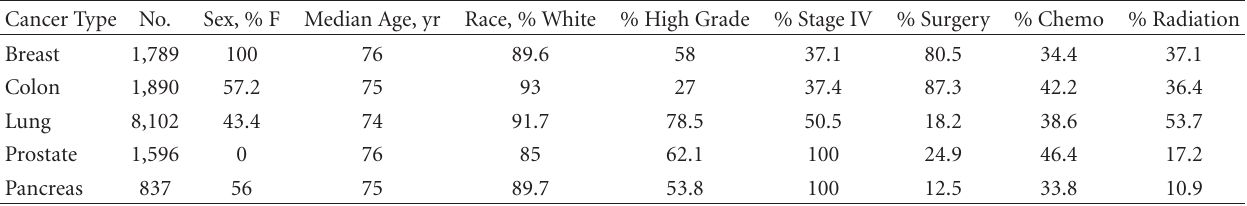
Table 1: Sample characteristics by cancer